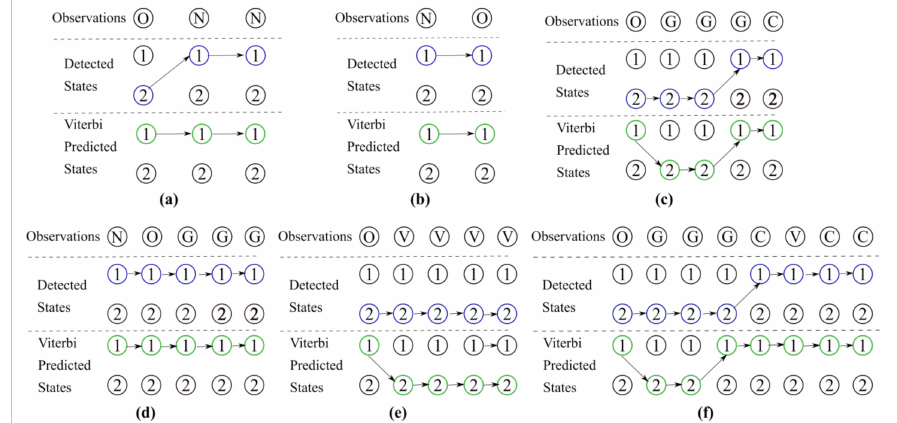
Figure 10. The trellis diagrams to compare sequences of hidden states as discerned from the HRV measurements, and those predicted by the Viterbi algorithm. ( a ) The reporting participant did not experience any symptoms after reporting the onset of SARS-Cov-2. ( b ) The participant had logged SARS-Cov-2 symptoms in accordance with an expected order of going from Onset to Generic symptoms observation. ( c ) The participants SARS-Cov-2 a ffl iction had become Critical. ( d ) This participant had also logged symptoms observations that were in an expected order of Negative to Onset, and then to Generic symptoms. ( e ) The participant had logged the Onset and next record was made when the a ffl iction had become Critical. ( f ) The longest observed sequence that also covered four di ff erent states of Onset, Generic, Critical and Ventilator support of SARS-Cov-2 a ffl